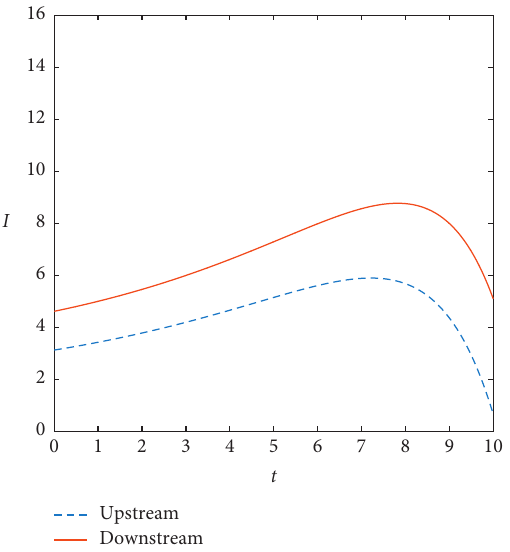
Figure 5: Optimal trajectory of pollution emission under coop- eration when T ⟶ ∞ .